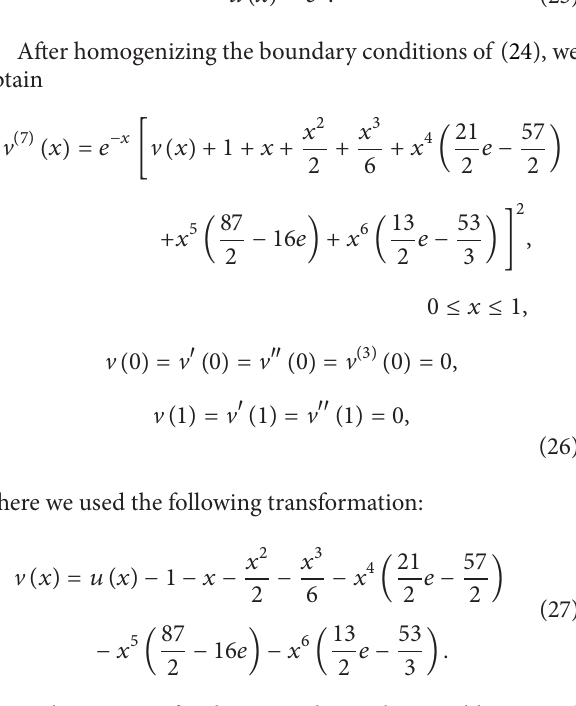
Figure 5: Comparison of analytical solution and RKHSM solution for Example 12.